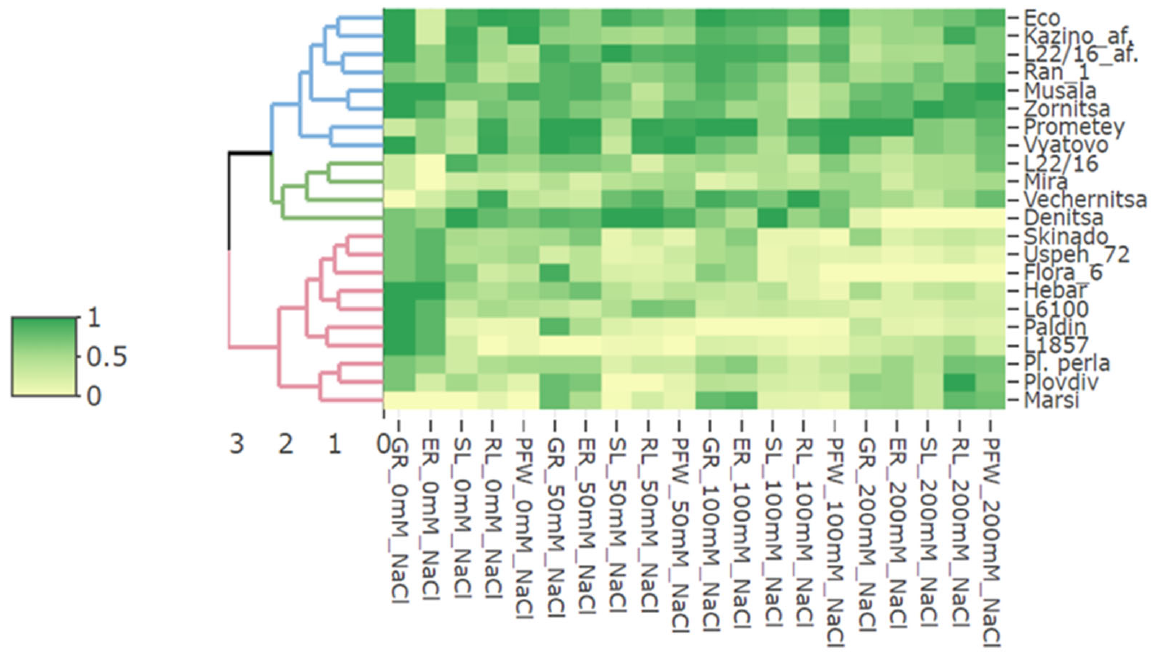
Figure 6. Heatmap based on the response of 22 garden pea genotypes under four levels of salinity stress.